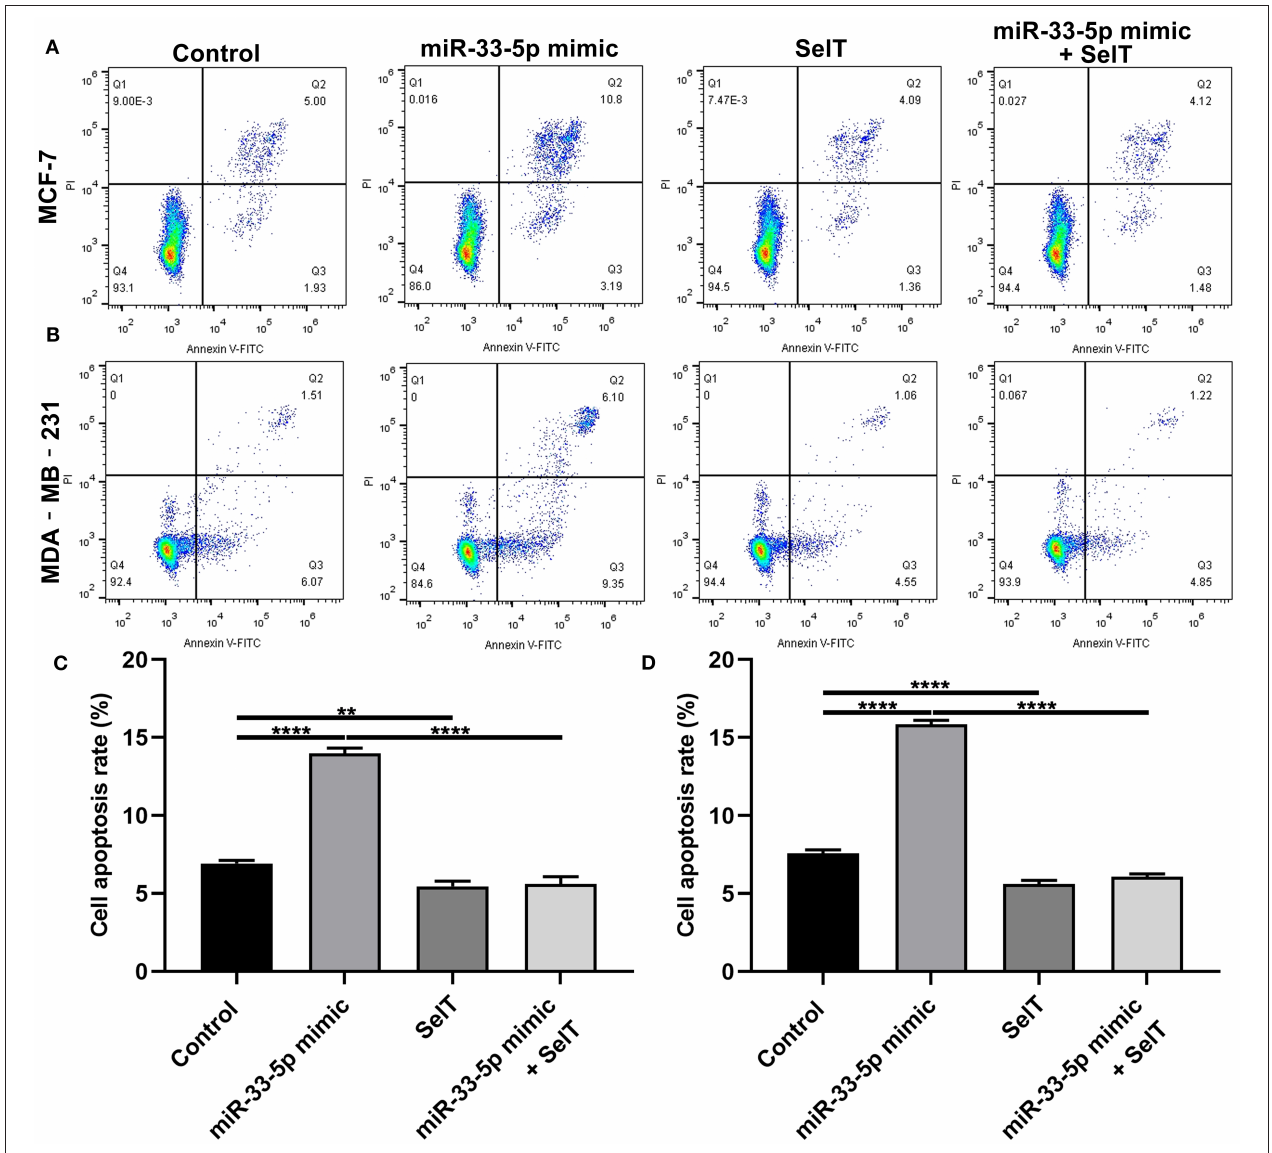
FIGURE 5 | hsa-miR-33-5p promotes the apoptosis of breast cancer cells via SelT. (A,B) Representative images of flow cytometry assay results. (C) MCF-7 as well as (D) MDA-MB-231 cell apoptosis was determined when transfected by hsa-miR-33-5p mimics and/or SelT. ** p < 0.01; **** p <